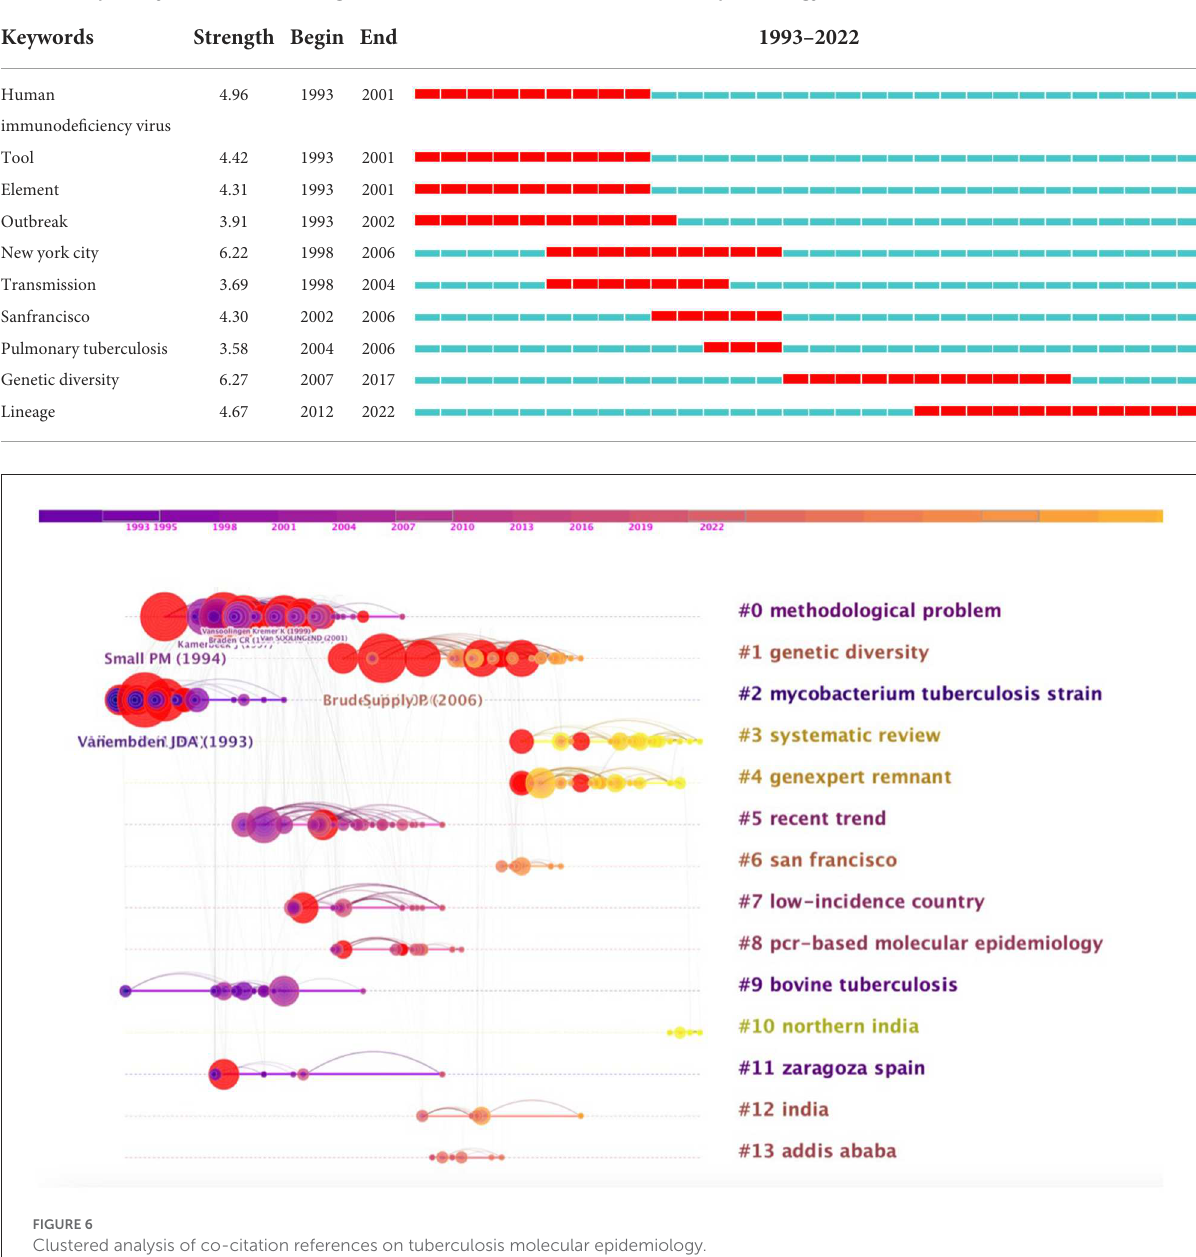
TABLE 3 Top 10 keywords with the strongest citation bursts of tuberculosis molecular epidemiology.